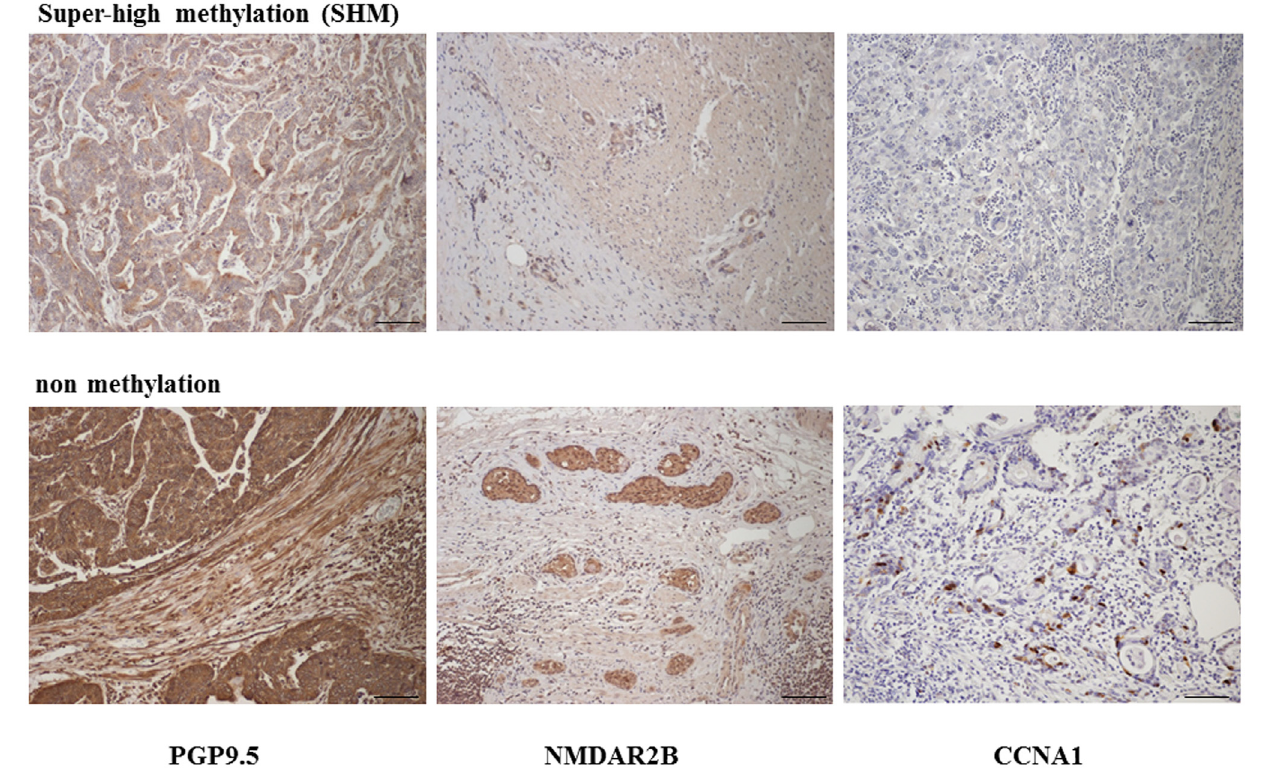
Fig 4. Immunohistochemical expression of PGP9.5, NMDAR2B, and CCNA1 in gastric cancer according to their methylation status. Immunohistochemical staining of PGP9.5, NMADR2B, and CCNA1 in primary tumor with or without hypermethylation of the promoter region of the corresponding gene (original magnification, X100, scale bars, 100 μ